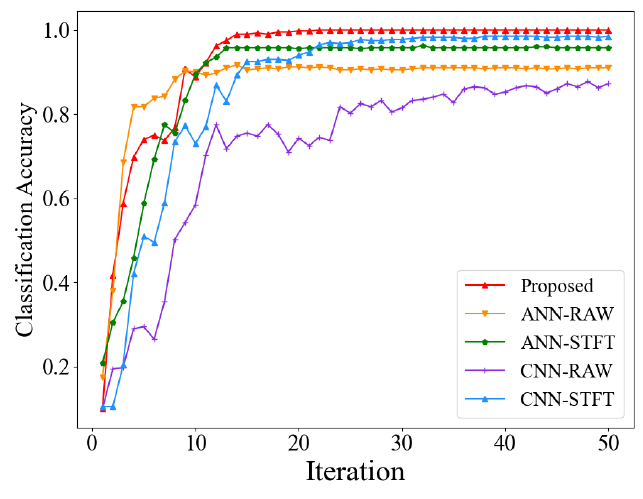
Figure 7. The classification accuracy between proposed and compared methods on CWRU dataset.